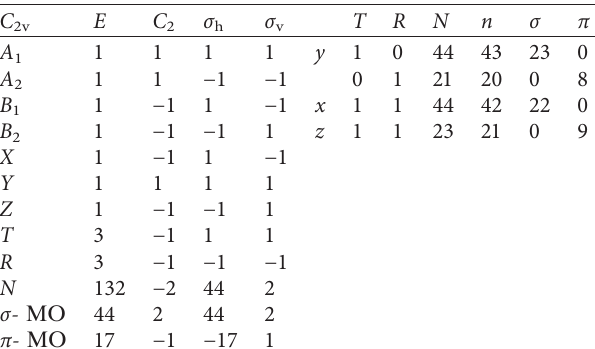
Table 1: Characters of the C 2v group and assigning the coordinate axes, translations ( T ), rotations ( R ), the number of vibrational modes ( n ), and σ -MO and π -MO of the PMD-I molecule to them. C 2v